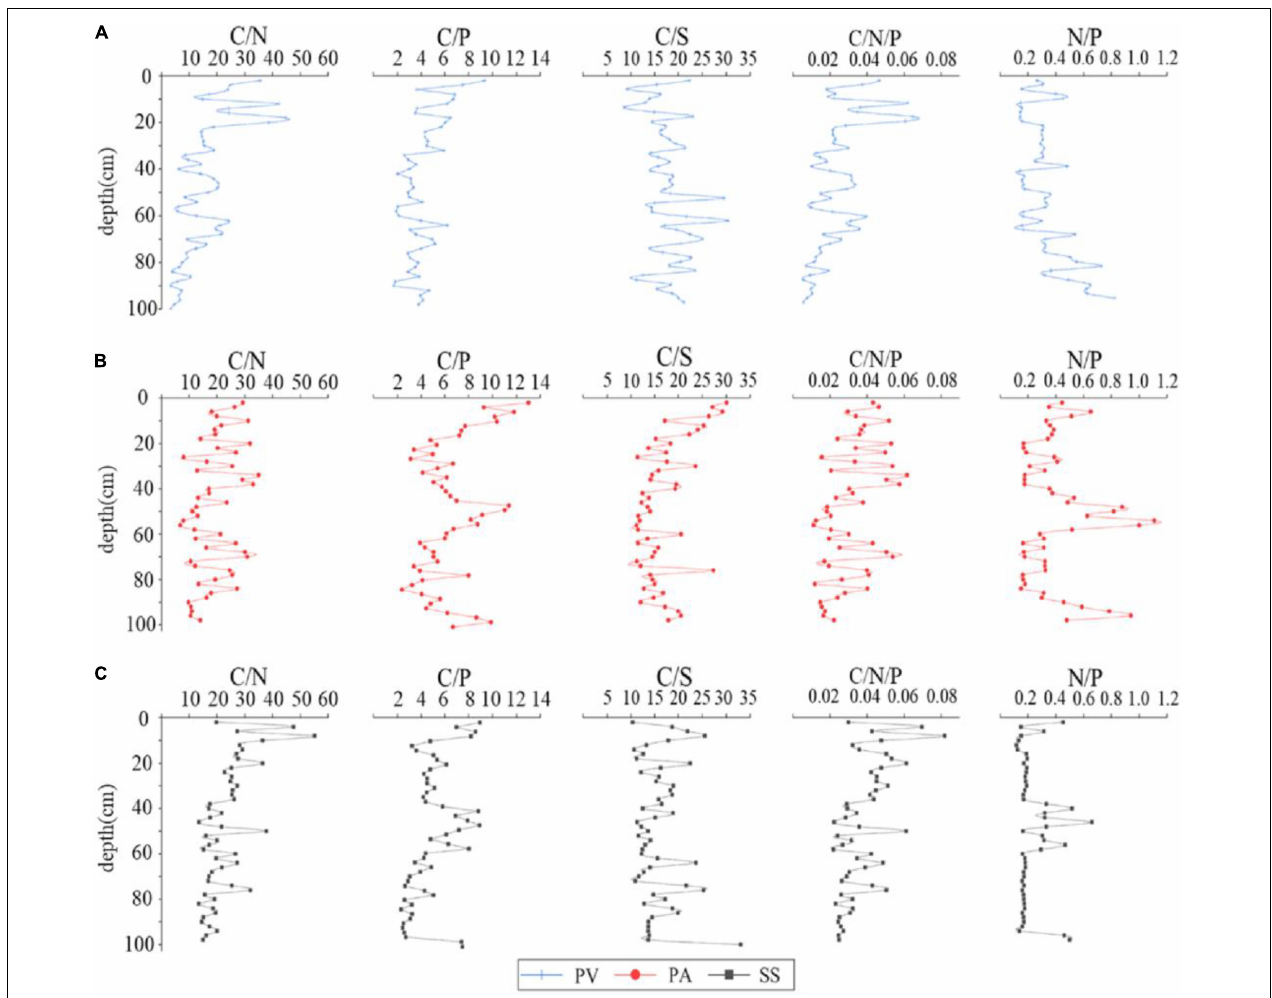
FIGURE 5 | Depth distributions of the ecological stoichiometric ratios along soil profiles under different water and salt conditions. PV (A) , PA (B) , SS (C) .